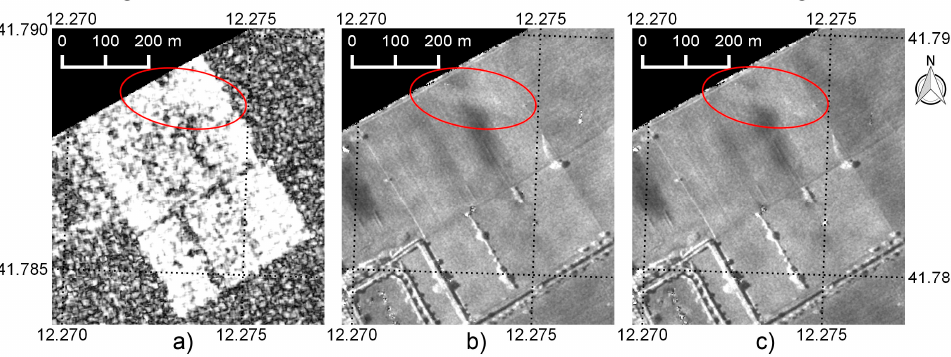
Figure 18. Example of a case in which very high coherence is observed over some fields in the CSK Stripmap pair with a temporal baseline of 16 days: from 22 April to 8 May 2011 ( a ); Residues of the buried Northern Canal are visible in the filtered σ 0 backscatter of both images of the pair, shown as red ellipse on filtered σ 0 image acquired on 22 April ( b ) and 8 May ( c ). COSMO SkyMed data provided by the Italian Space Agency.